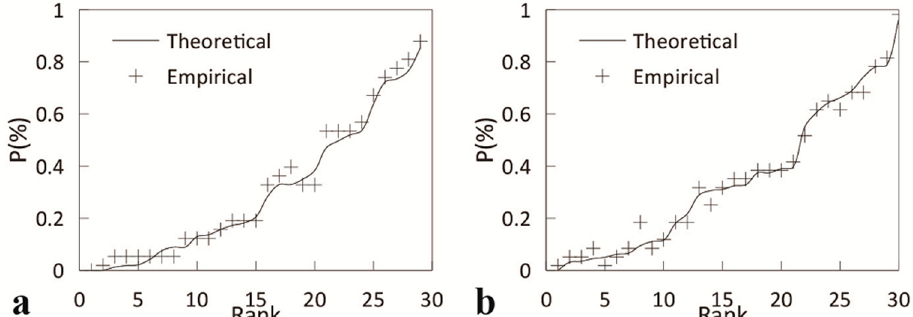
Figure 9. Fitting of the empirical frequencies and theoretical probabilities for flood occurrence dates and magnitudes. ( a ) Flood occurrence dates. ( b ) Flood magnitudes.